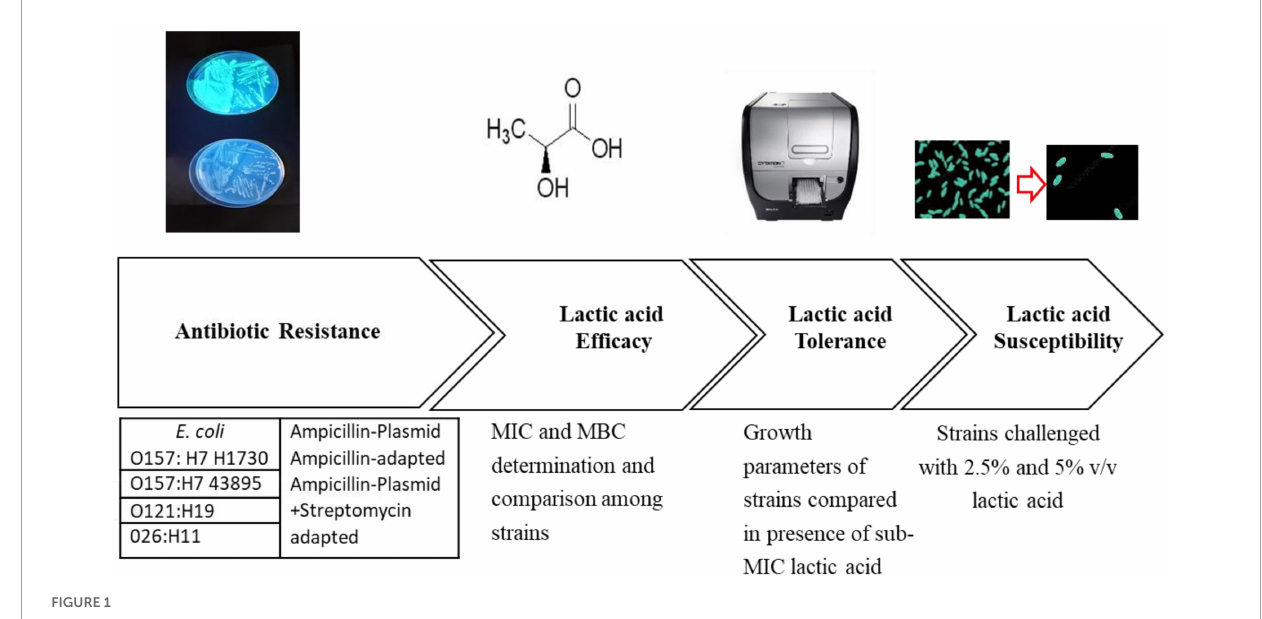
FIGURE1 Experimental overview.